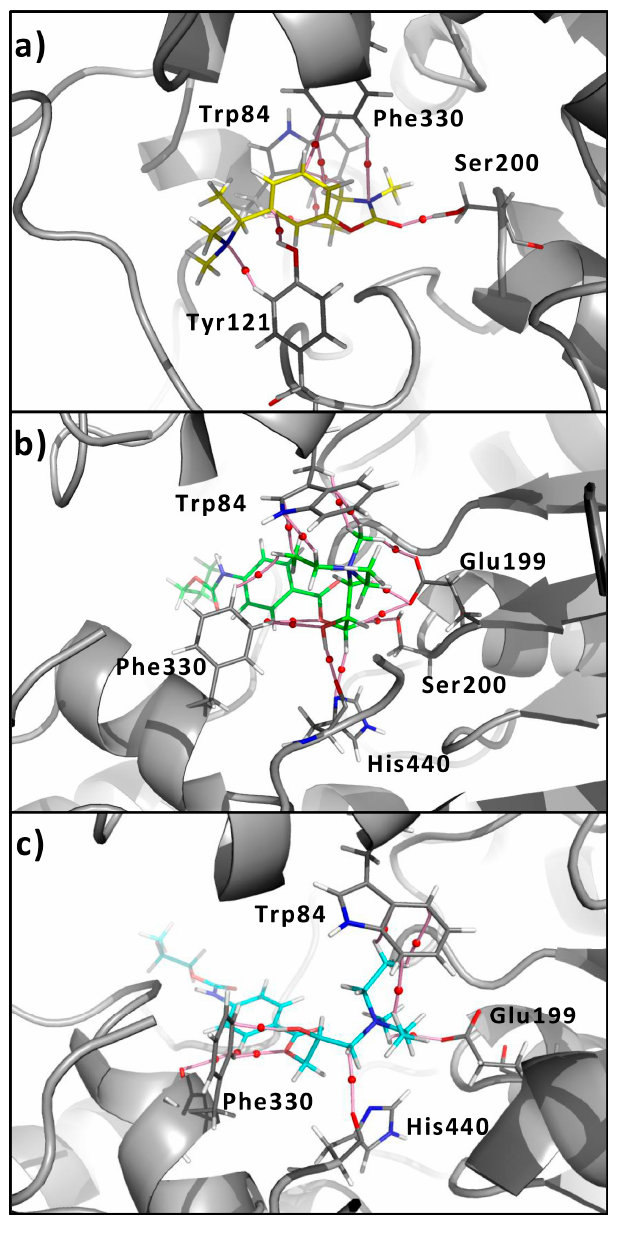
Figure 2. Molecular graph of the non-covalent interactions between the main residues of AChE with ( a ) rivastigmine (yellow sticks); ( b ) compound ( R )- 6h (green sticks); and ( c ) ( S )- 6h (light-blue sticks). The elements of the electron density topology are shown. The bond paths connecting the nuclei are represented in pink sticks and the bond critical points are shown as red spheres.